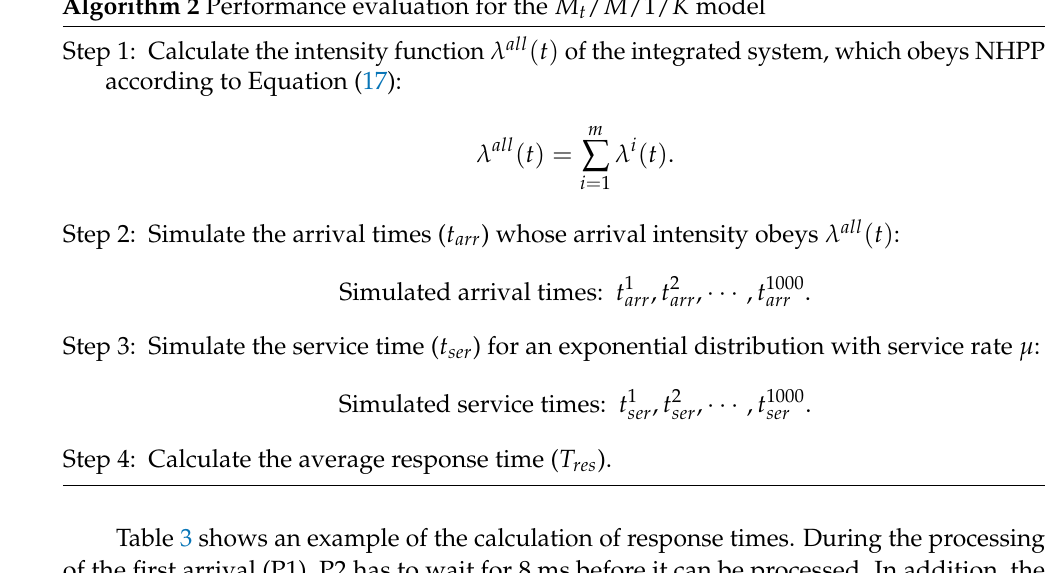
Algorithm 2 Performance evaluation for the M t / M /1/ K model